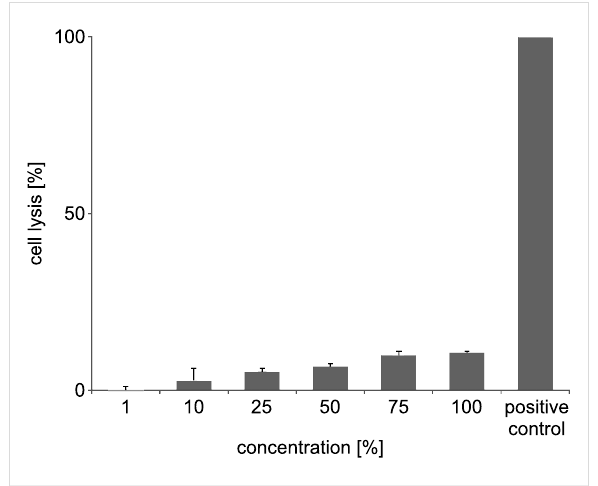
Figure 4: Cell lysis of HEK-293 cells induced by (sC18) 2 after 1 h incu- bation. Experiments were conducted in triplicate with n = 2. Error bars represent the standard